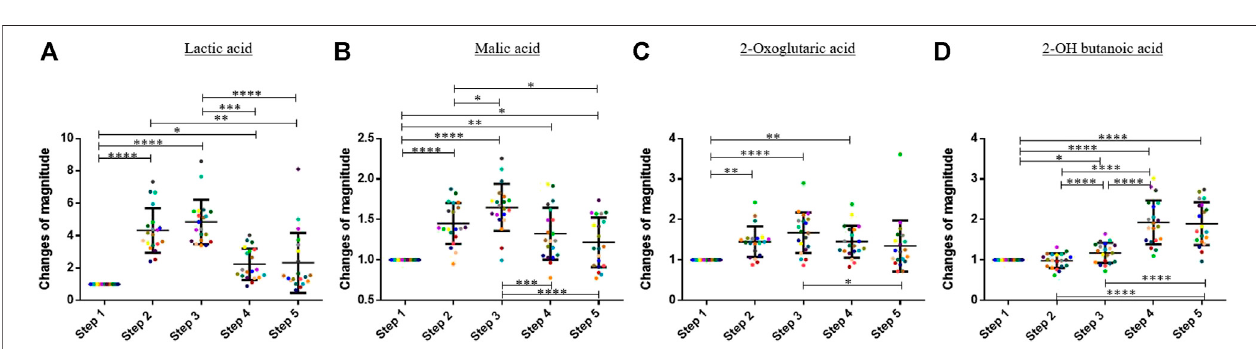
FIGURE 3 | Graphs representing the “ changes of magnitude ” obtained during the fi ve steps of the study. Step 1: before physical exercise, step 2: after 400-m warm-up and 800-m running, step 3: after the completion of 1,600-m running, step 4: 30 min after fi nishing the exercise, and step 5: 60 min after fi nishing the exercise. Each color represents one participant. Black lines represent the mean ± SD of the change of magnitude factor obtained at each step ( n (cid:2) 20). (A) Lactic acid, (B) malic acid, (C) oxoglutaric acid, (D) 2-OH butanoic acid: organic acids for which an increase in blood concentration was observed during and/or after the exercise (*, p -value < 0.05; **, p -value < 0.01; ***, p -value < 0.001; ****, and p -value <